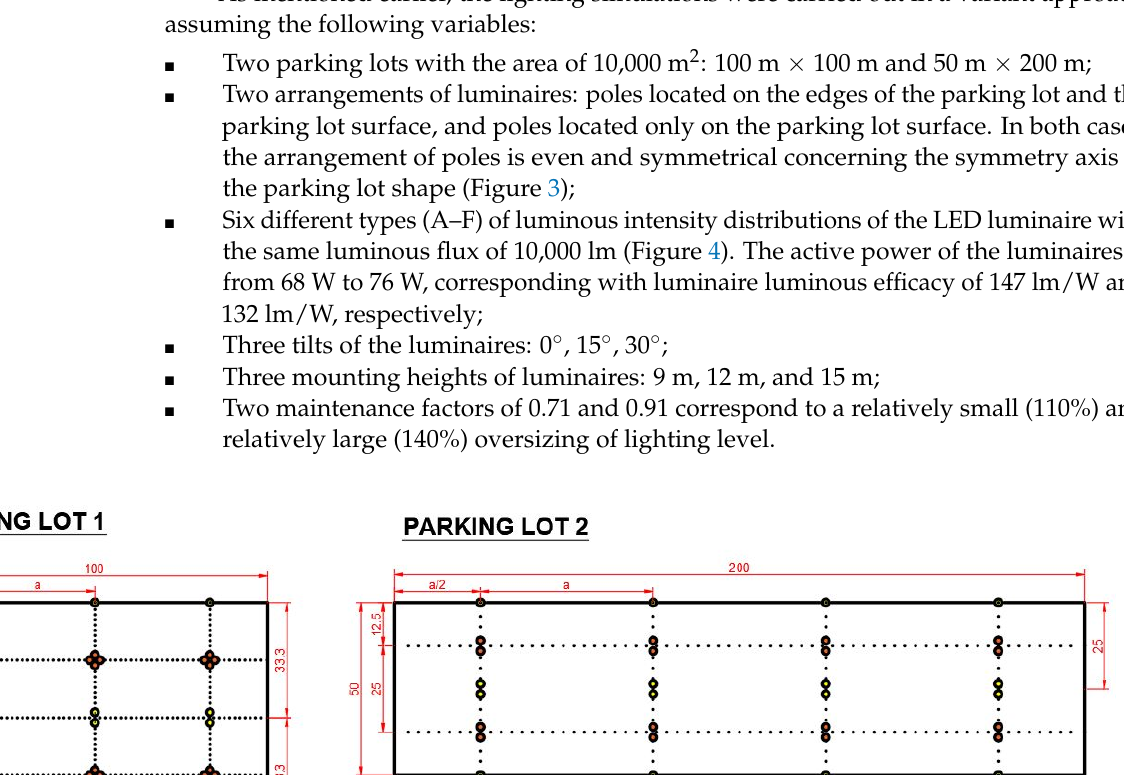
Table 2. Se tt led requirements for particular parameters.